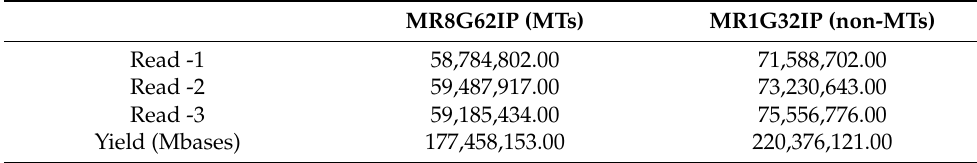
Table 1. Mapping statistics for quality filtered reads generated for lines with MTs and non- MTs induction.